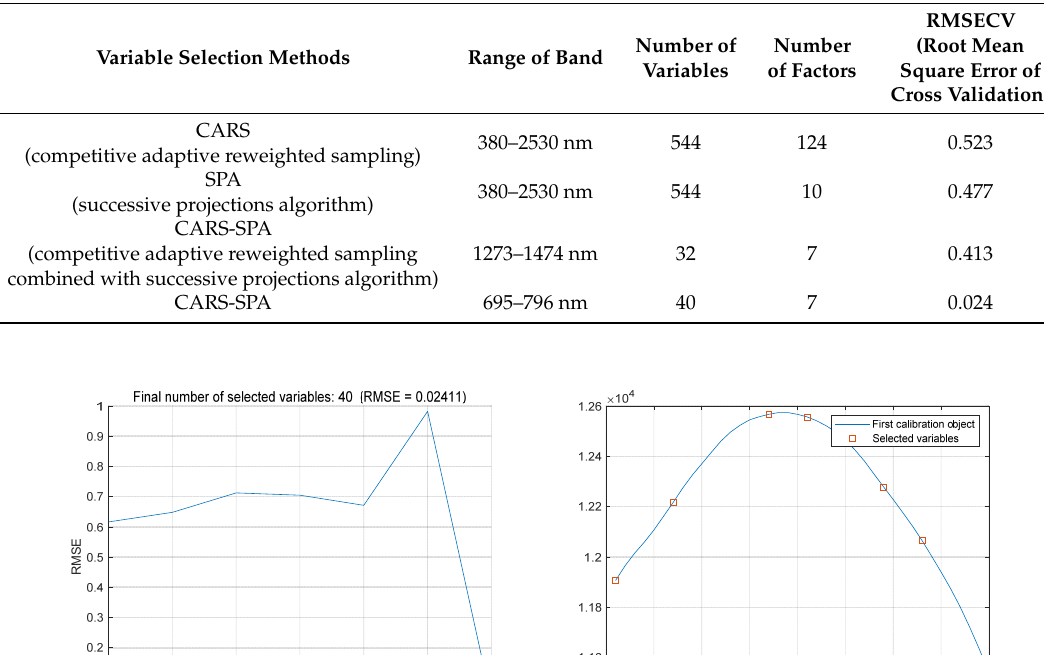
Figure 7. CARS algorithm processing result of the unprocessed full-band spectrum. Table 3. Performance of models built by CARS-SPA algorithm.